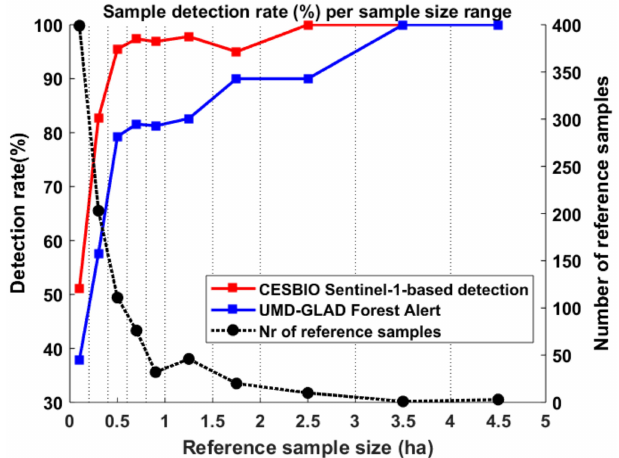
Figure 13. Detection rate of deforestation events per reference sample size range (delimited by thin black dashed lines), for the S1-only method from CESBIO (red) and for the UMD-GLAD (University of Maryland Global Land Analysis and Discovery) Forest Alert dataset (blue). The number of reference samples available in each size range is also shown (thick black dashed line).